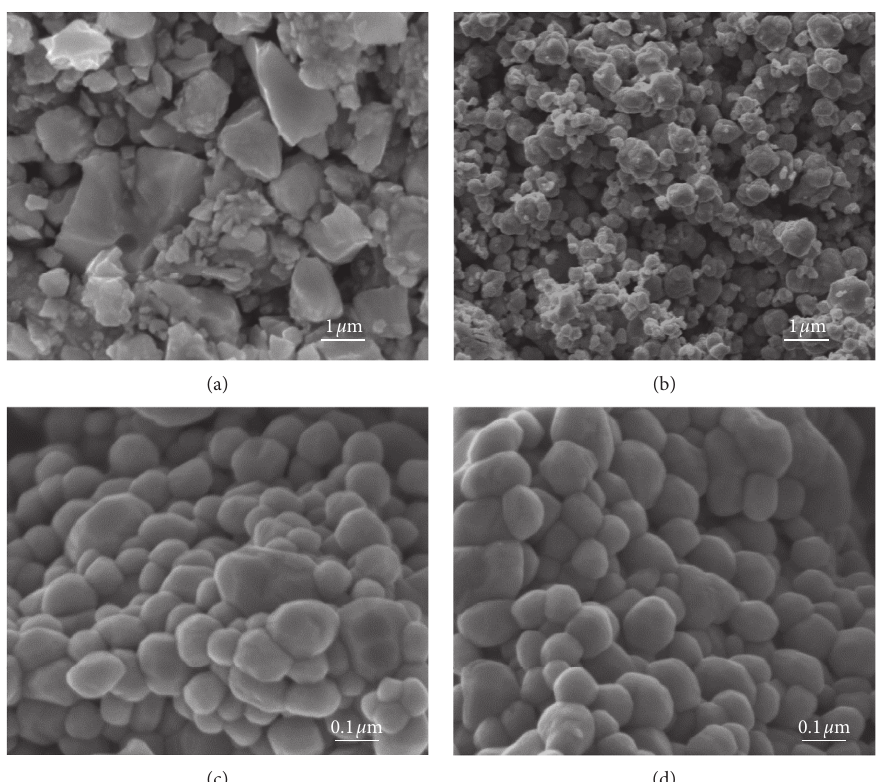
Figure 5: Morphology of (Ti, W Mo, Ta) (C, N) powders, as obtained by SEM. (a) Ball mill 3h; (b) ball mill 6h; (c) ball mill 9h; (d) ball mill 12h.